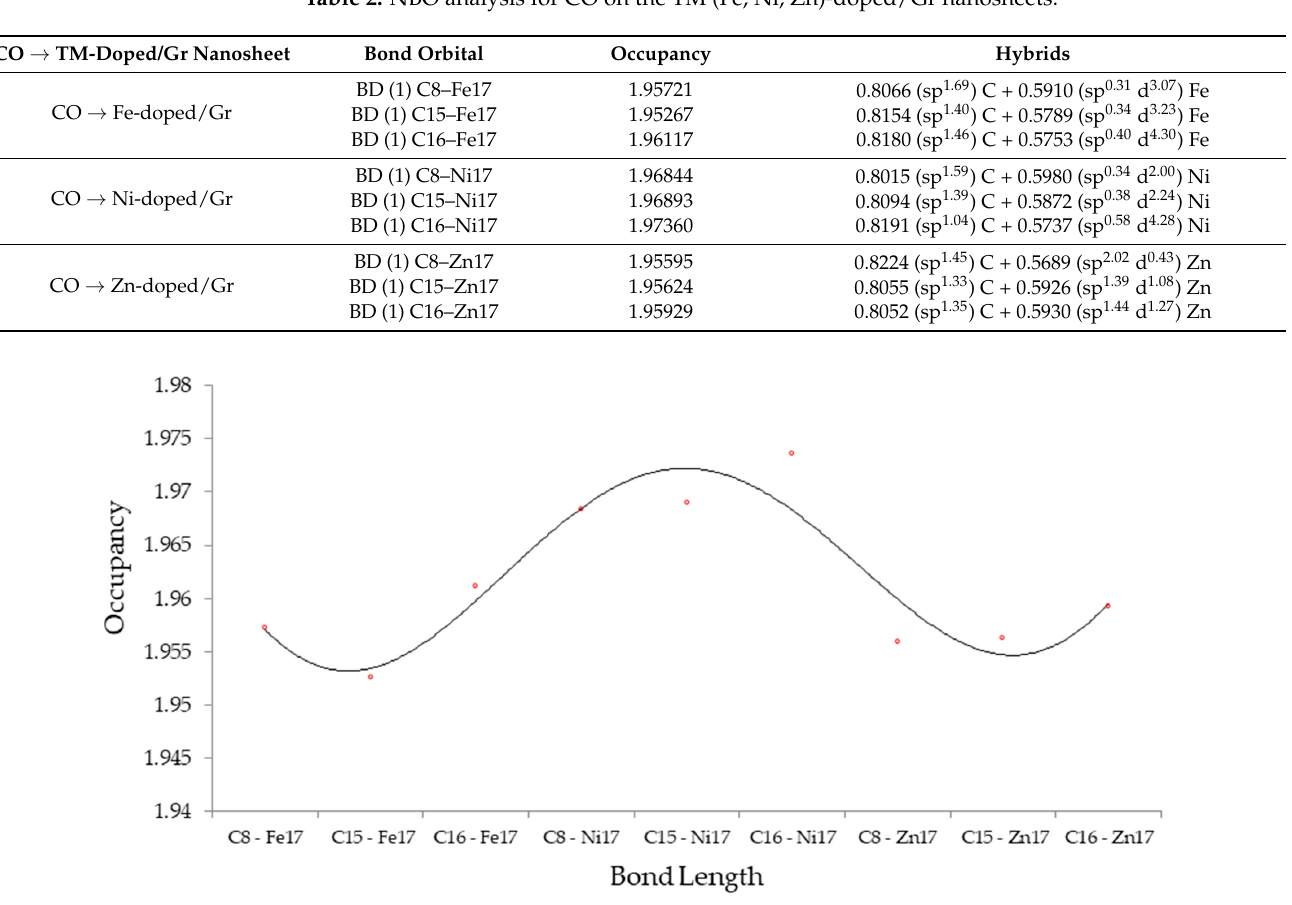
Figure 2. Occupancy fluctuation extracted from the NBO method for bond lengths of C-Fe, C-Ni and C-Zn through adsorption of CO on the TM (Fe, Ni, Zn)-doped/Gr nanosheets. In Figure 2, fluctuations are observed in the occupancies of the natural bond orbitals for the CO → Fe-doped, CO → Fe-doped, and CO → Fe-doped graphene nanosheets through the Langmuir adsorption process, indicating that the active oxygen atom in car- bon monoxide is close to the nanosheet’s surface. The bond orbitals of C8–Ni17, C15–Ni17, and C16–Ni17 in the adsorption of CO in the Ni-doped/Gr, show the maximum occu- pancy.